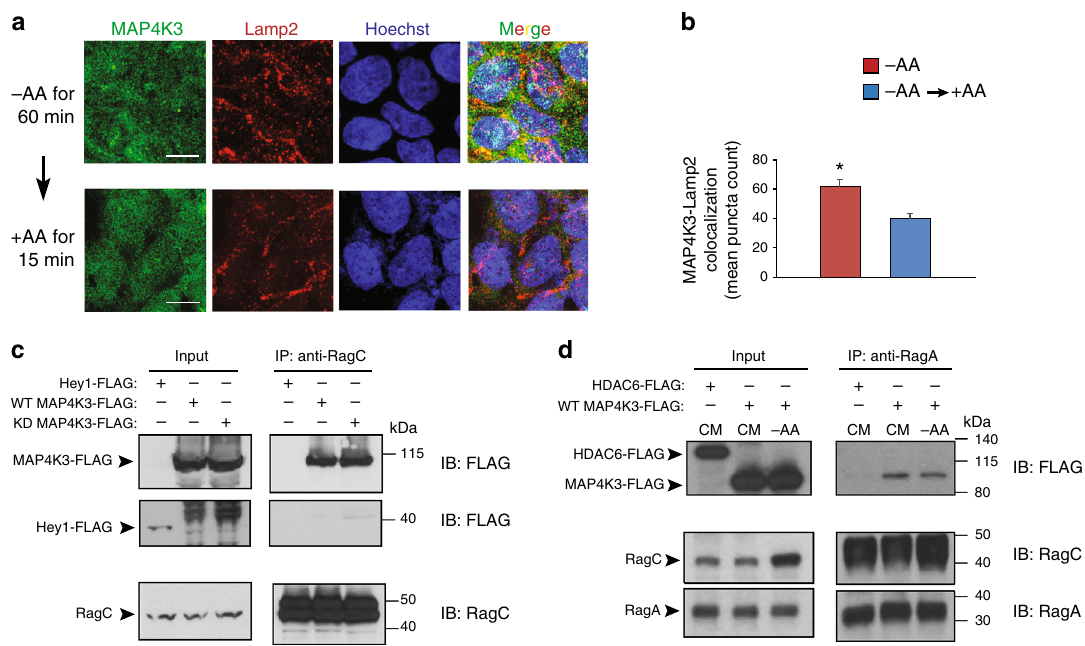
Fig. 8 MAP4K3 preferentially localizes to lysosomes upon amino acid depletion and interacts with Rag GTPases. a HEK293A cells were starved of amino acids for 60 min and then switched to amino acid-replete media for 15 min, after which cells were fi xed and immunostained for endogenous MAP4K3 and Lamp2. It is noteworthy that extensive MAP4K3 – Lamp2 colocalization upon amino acid starvation diminishes with resupply of amino acids. Scale bar = 10 μ m. b Quanti fi cation of MAP4K3 – Lamp2 colocalization in a . We counted the number of colocalized puncta in 10 cells per fi eld for 3 fi elds per condition, performed in triplicate, and determined the mean puncta count per condition. * P < 0.05; two-tailed t -test. c MAP4K3 physically interacts with RagC. WT HEK293A cells were transfected with an expression vector for Hey1-FLAG, WT-MAP4K3-FLAG, or kinase dead (KD)-MAP4K3-FLAG as indicated, and cell lysates and RagC immunoprecipitates were subjected to immunoblotting. d MAP4K3 interaction with RagA is dependent on amino acid status. WT HEK293A cells cultured in complete media (CM) or subjected to amino acid starvation ( – AA) were transfected with an expression vector for either HDAC6-FLAG or WT-MAP4K3-FLAG as indicated, and cell lysates and RagA immunoprecipitates were subjected to immunoblotting. All experiments were performed in